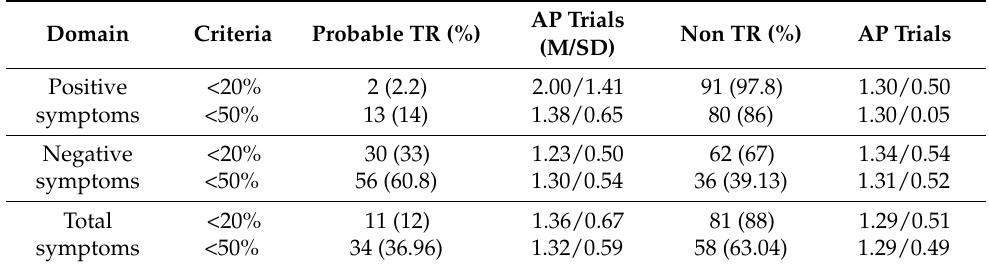
Table 2. Rates of Probable TR and mean number of antipsychotic trials using various criteria.